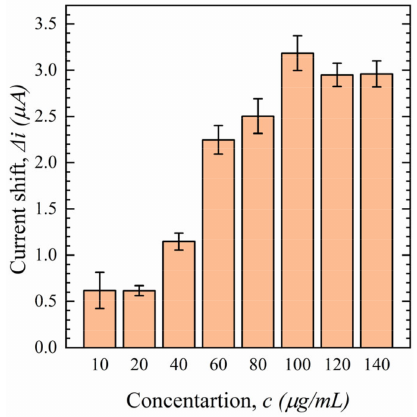
Figure 8. Effect of different S1-Ab concentrations on sensor performance in 100 nM S protein in 0.1 M PBS ( n =